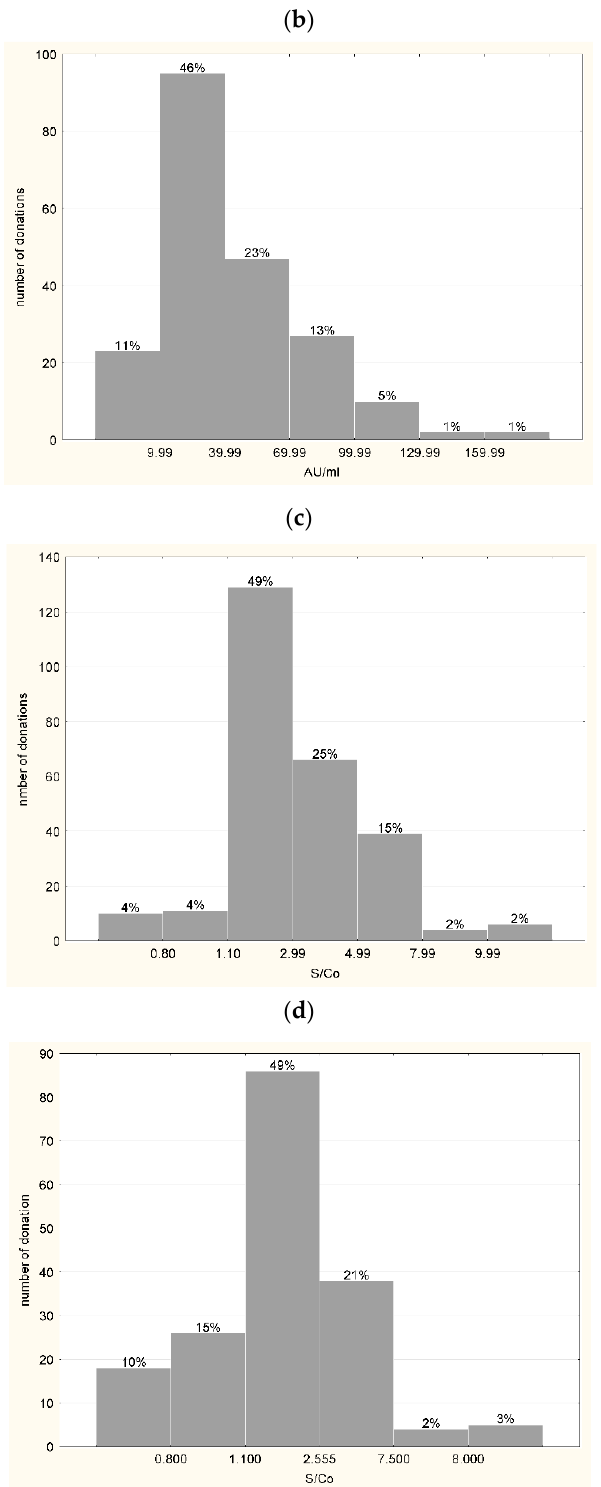
Figure 2. Histogram of anti-SARS-CoV-2 antibodies reactivity in EIA assays in convalescent plasma units used for the production of hIHGG anti-SARS-CoV-2: ( a ) Wantai anti-S1 RBD Ab Total—IgM, IgA and IgG (n = 270, S/Co < 1 negative result, S/Co > 19.9 over result); ( b ) iFlash anti-S1 IgG (n = 206, <10 AU/mL — negative); ( c ) Euroimmun anti-S1 IgG (n = 265, S/Co < 0.8 negative, 0.8 – 1.1 gray zone, >1.1 positive); ( d ) Euroimmun IgA (n = 177, S/Co < 0.8 negative, 0.8–1.1 gray zone, >1.1 positive). Above bars % of tested samples is presented.